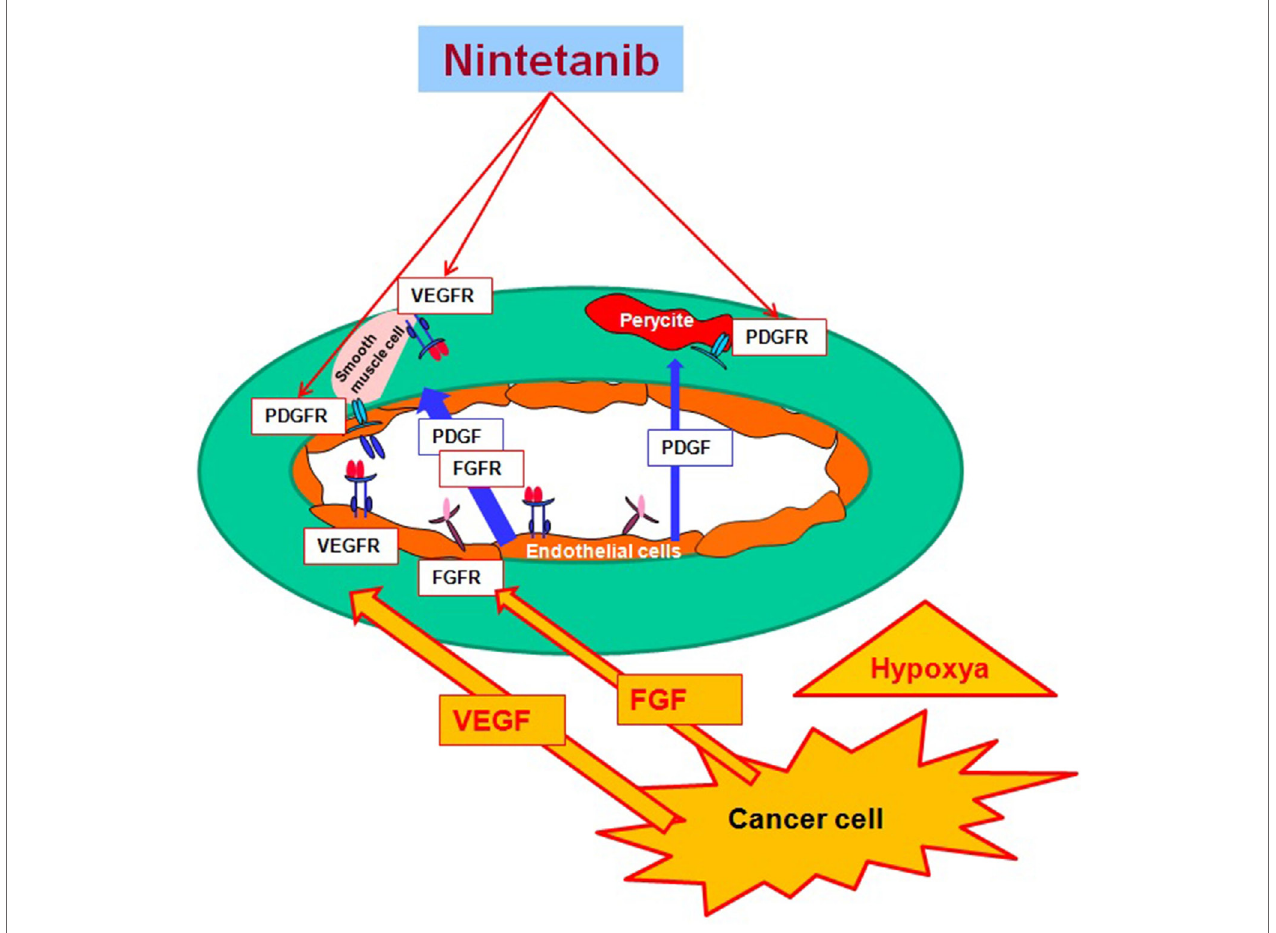
FiGURe 2 | Nintedanib and targeted proangiogenic pathway